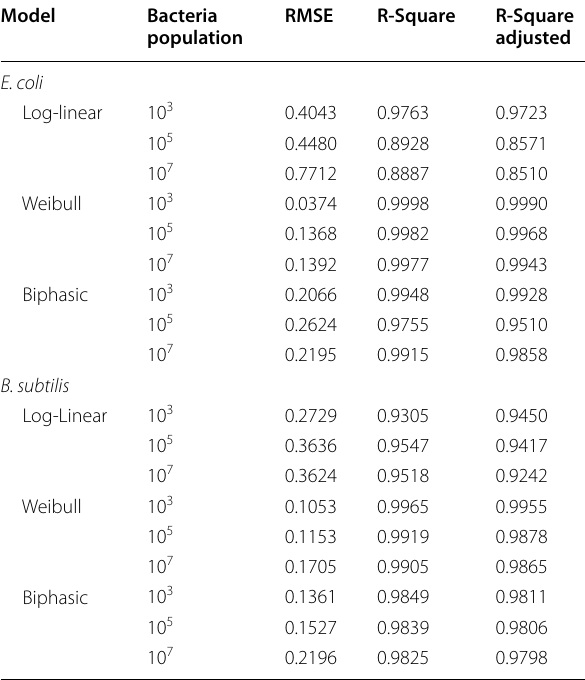
Table 1 Kinetic models used to describe the inactivation process